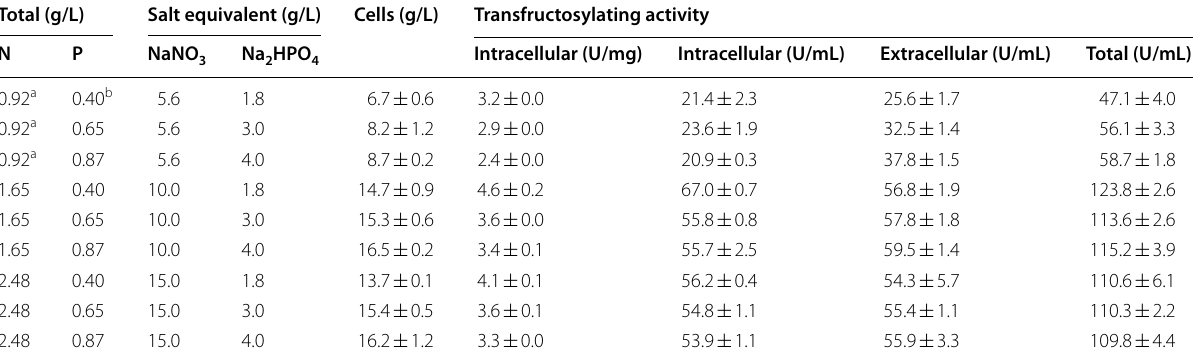
Table 2 Transfructosylating activities of intracellular, extracellular and total enzymes after 72 h of shake-flask cultivation with different levels of nitrogen and